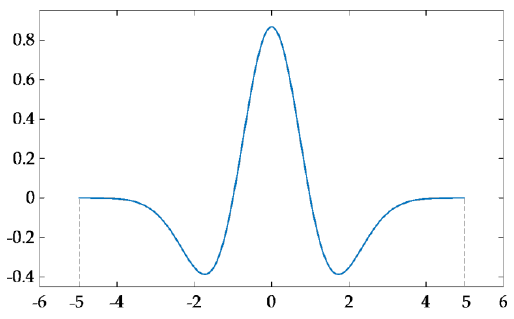
Figure 3. The plot of ‘Mexican Hat’ wavelet.